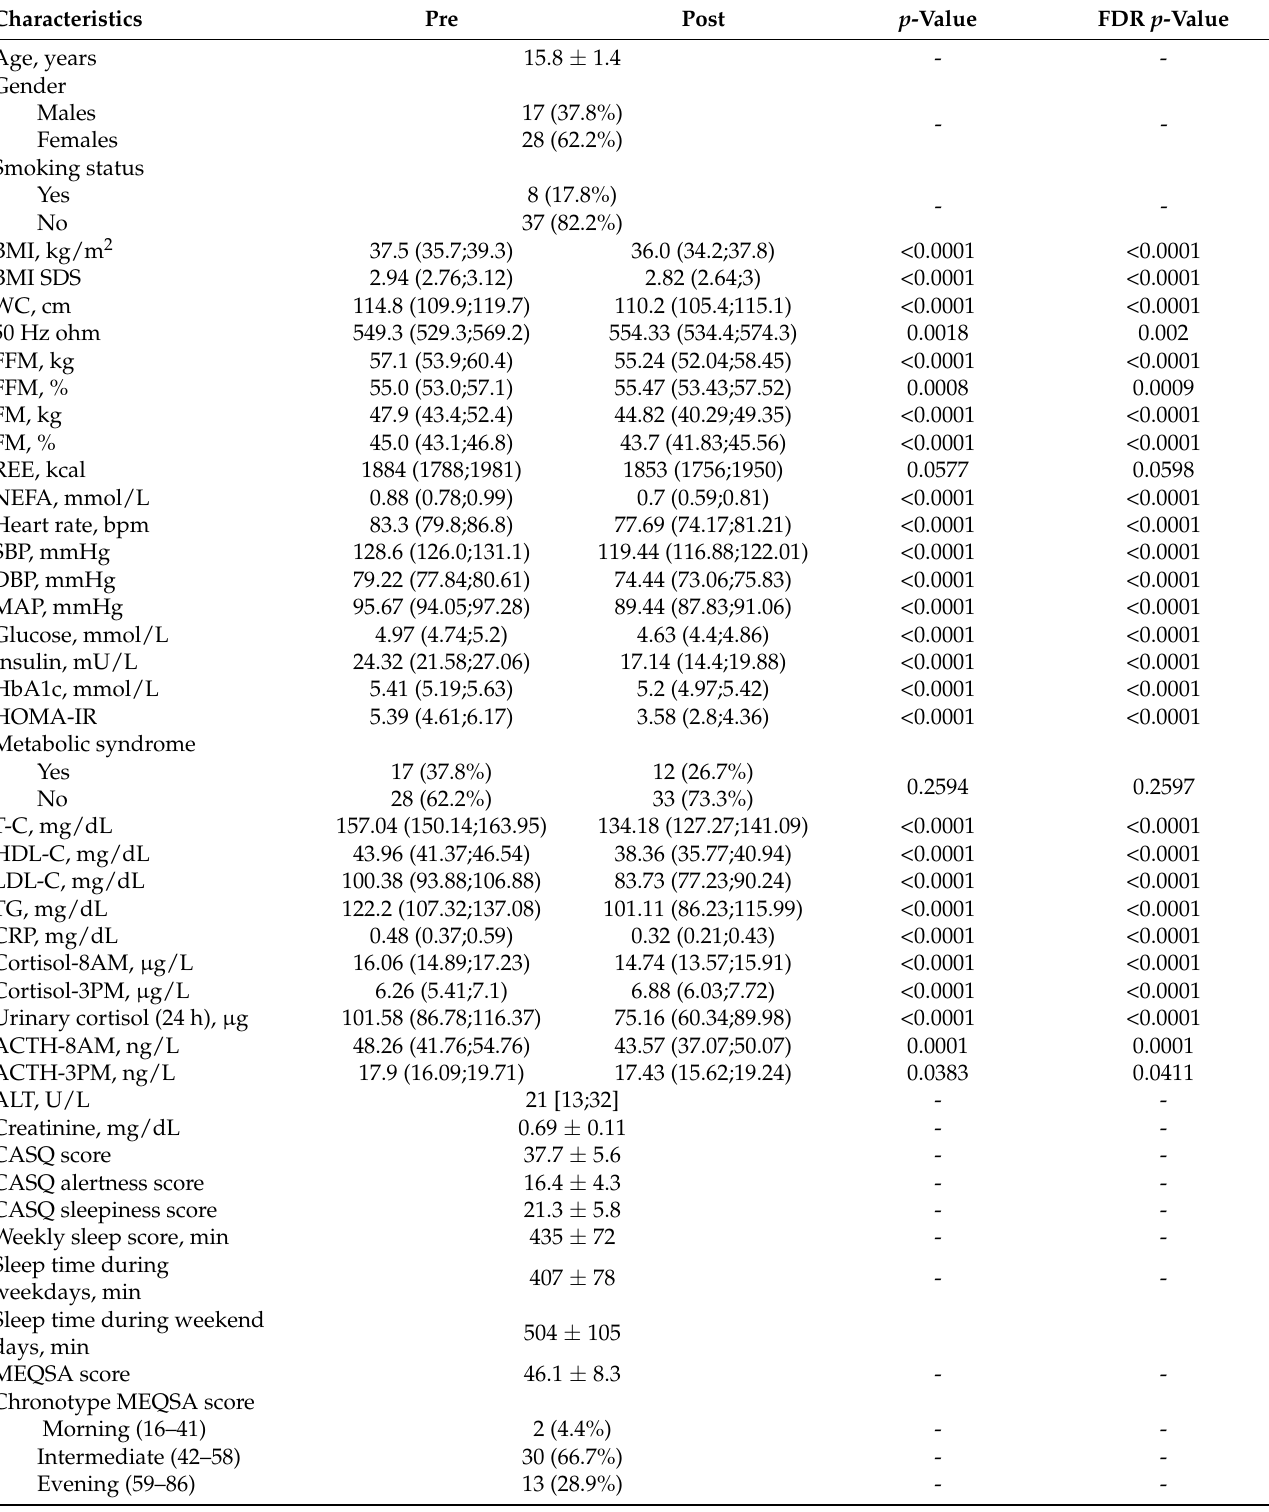
Table 1. Demographic, lifestyle, biochemical and clinical characteristics of study participants: com- parison pre vs. post BWRP (N =